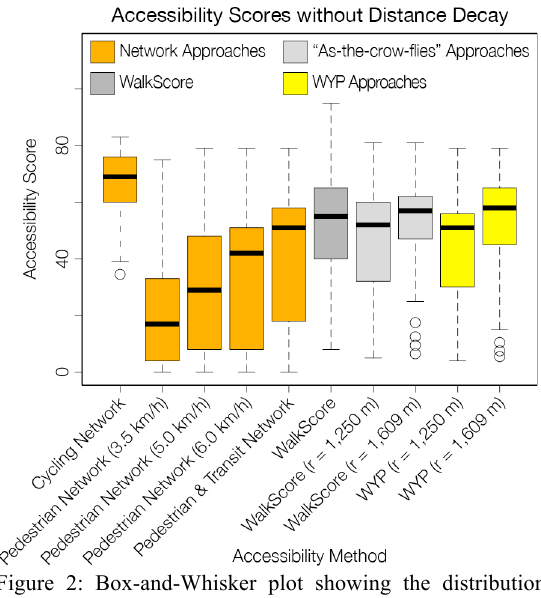
Figure 2: Box-and-Whisker plot showing the distribution of score values between different modelling methods, including the original WalkScore model.